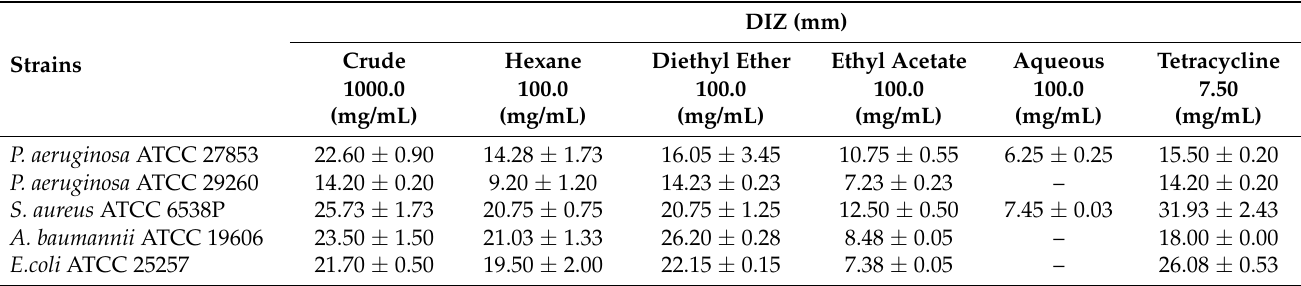
The concentration for SW1535 cells viability treated via various liquid-liquid extracts and H 2 O 2 was confirmed beforehand (data not shown), and then various liquid-liquid extracts and H 2 O 2 co-treatments were used to measure the cell viability. Figure 3a indicates that the ethyl ether extract and ethyl acetate extract resulted in higher survival rate and better cytoprotective ability than other extracts. Figure 3b shows the scavenging ability versus the different concentrations of various liquid-liquid extracts upon doing a DPPH assay. The ethyl ether extract showed the best antioxidant ability, and its EC 50 (concentration for 50% of maximal effect) was of 7.19 ± 0.8 µ g/mL, only slightly inferior to that of vitamin C (EC 50 = 4.60 ± 0.66 µ g/mL). The lower the EC 50 , the stronger the ability to capture free radicals. Therefore, the ethyl ether fraction was further purified through column chromatography based on extract yield, total polyphenols and flavonoid contents, antimicrobial activity, cell viability, and antioxidant capacity.